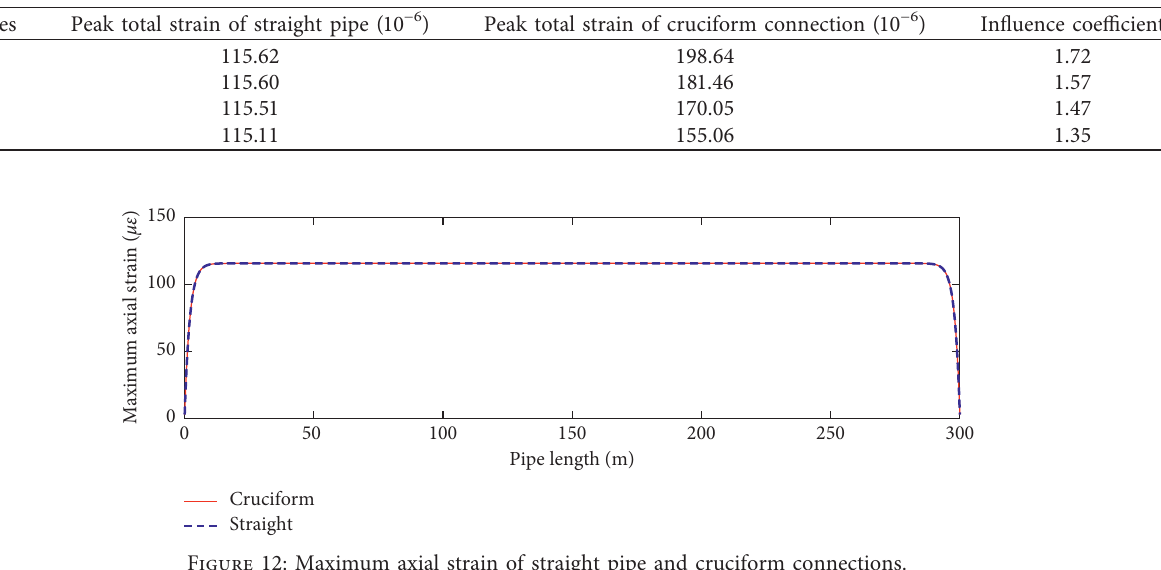
Figure 12: Maximum axial strain of straight pipe and cruciform connections.